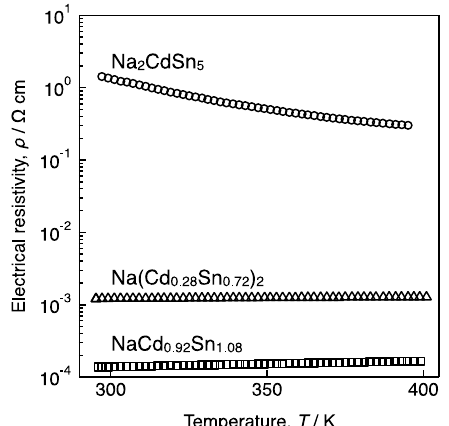
Figure 5. Electrical resistivities of the polycrystalline samples of NaCd 0.92 Sn 1.08 (open squares), Na(Cd 0.28 Sn 0.72 ) 2 (open triangles), and Na 2 CdSn 5 (open circles).